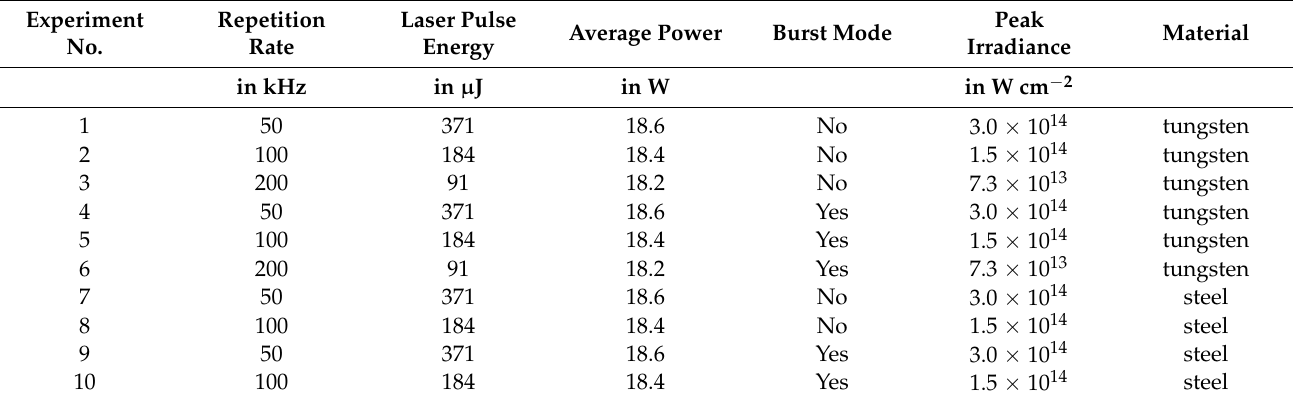
Table 1. Experimental processing